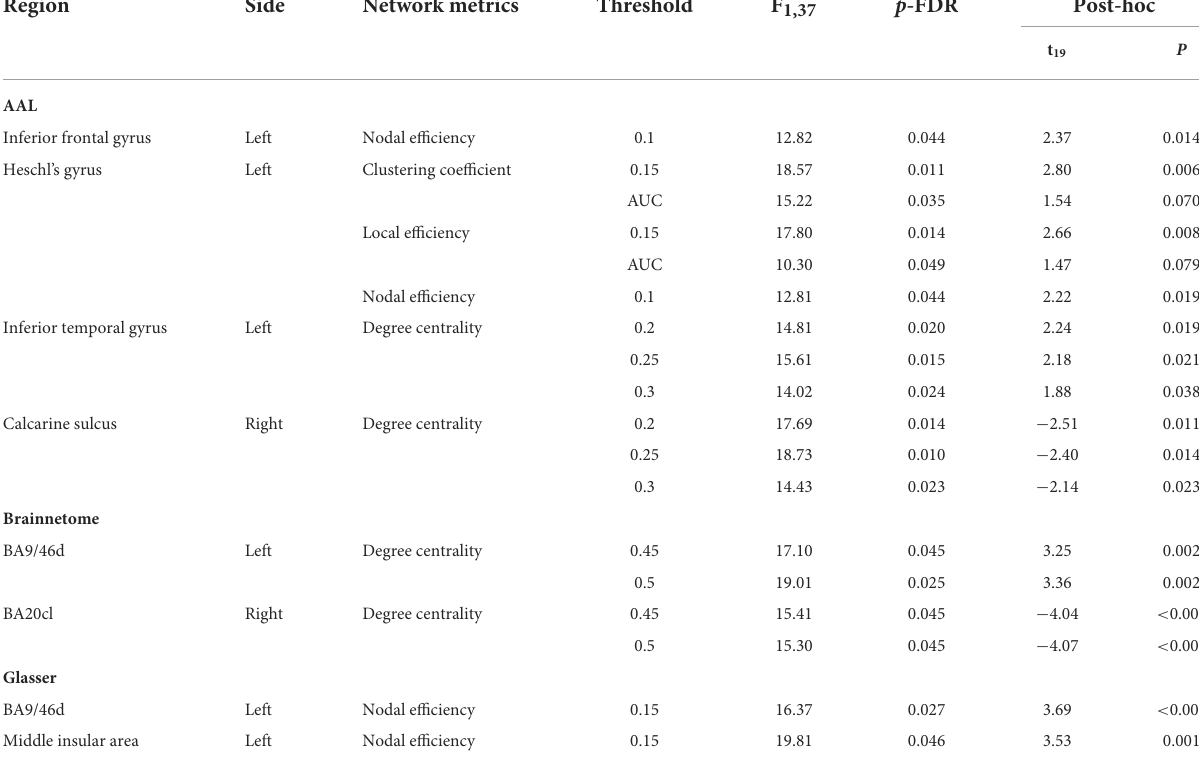
TABLE 2 Significant results of the mixed-design ANOVA for the local network metrics at different thresholds. Region Side